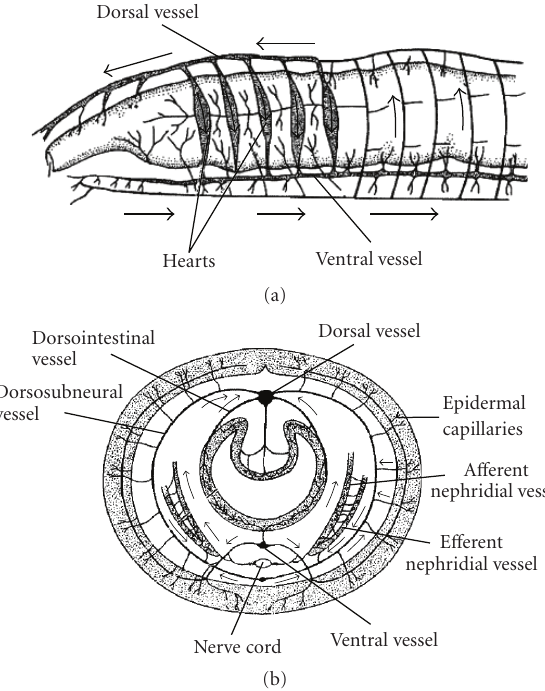
Figure 2: The annelid circulatory system, though a low pressure system, contains contractile vessels for pumps and a highly branched vascular system. It lacks an endothelial lining. (a) Lon- gitudinal section, (b) cross-section of the earthworm ( Lumbricus ) (adapted from R. C. Brusca and G. J. Brusca, [4]).